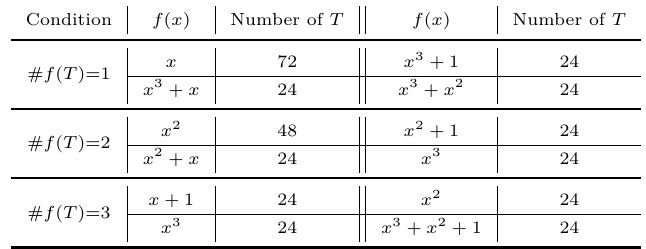
Table 1: Matrix polynomials on the 4 × 4 binary matrix polynomial residue rings Condition f ( x ) Number of T f ( x ) Number of